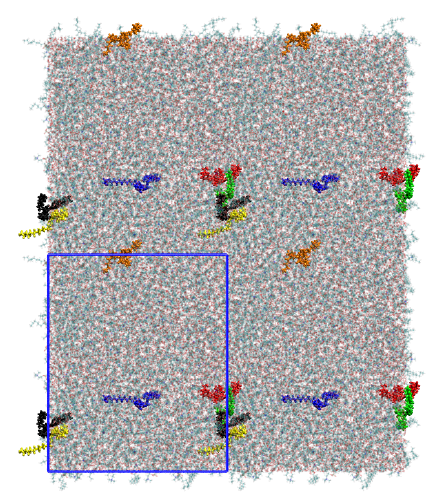
Figure 3. A snapshot of the simulated system as a top view after an equilibration time of 20 ns. The polyphiles are colored and a clustering can be observed for some of the molecules. The simulation cell dimensions are shown as blue